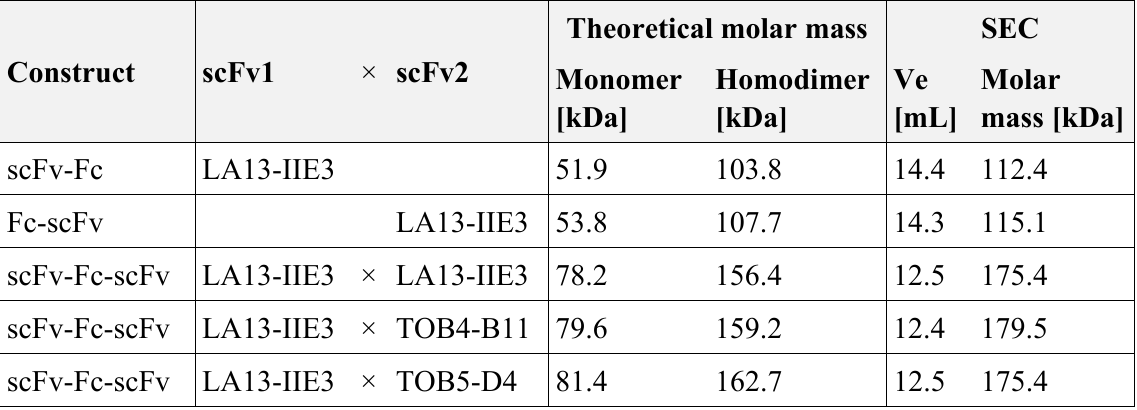
Table 1. Molar masses of LA13-IIE3 based scFv-Fc, Fc-scFv and scFv-Fc-scFv antibodies calculated from the amino acid sequences (for monomer and homodimer) and from retention volumes (Ve) measured by